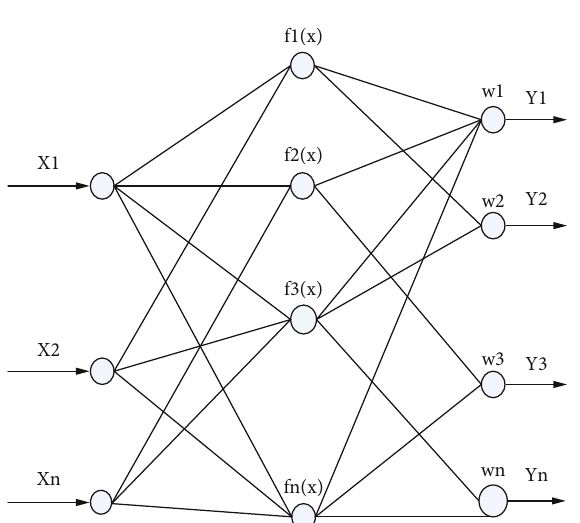
Figure 6: Fully connected layer network